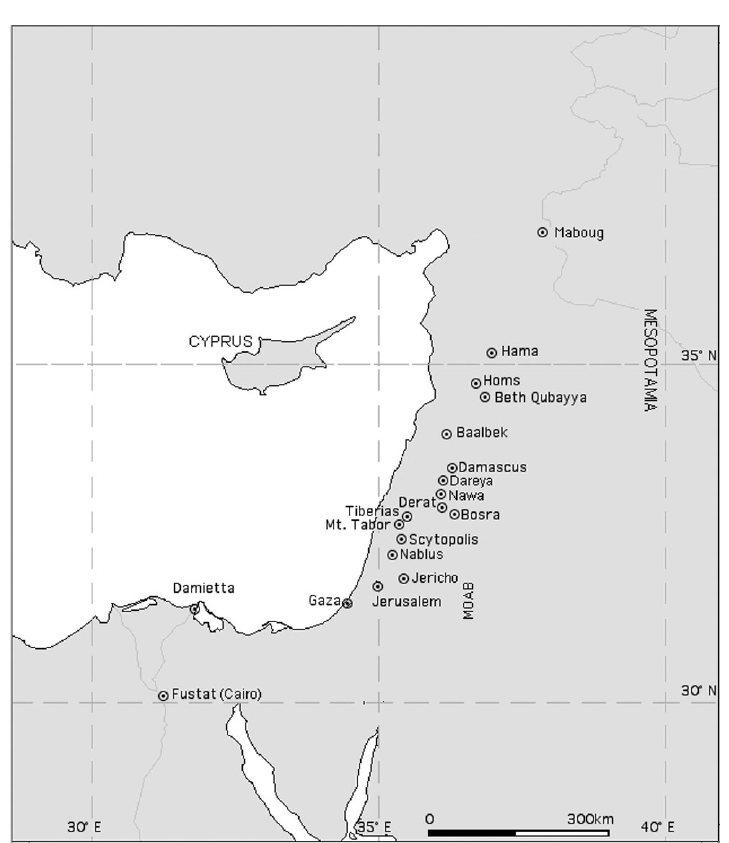
Fig. 6. Orientation map for the 747-749 A.D.